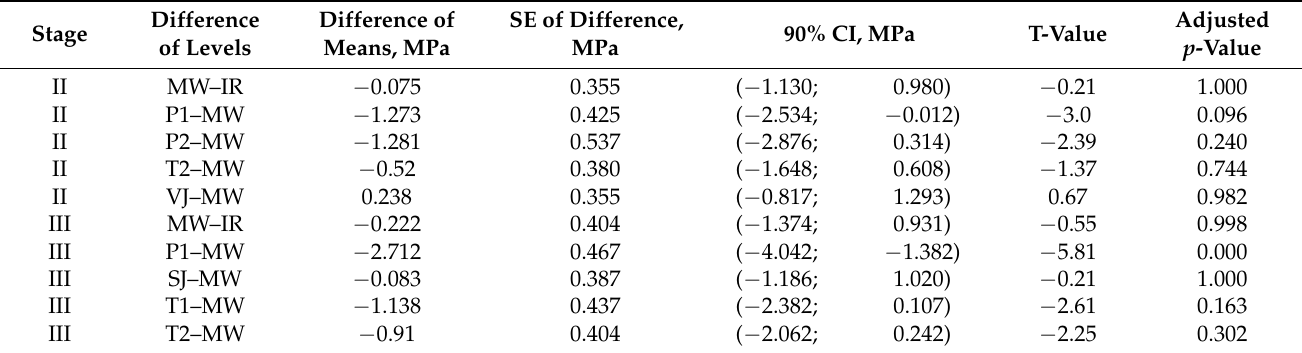
Table 8. Tukey’s pairwise comparison for TSRST test–maximum stress.